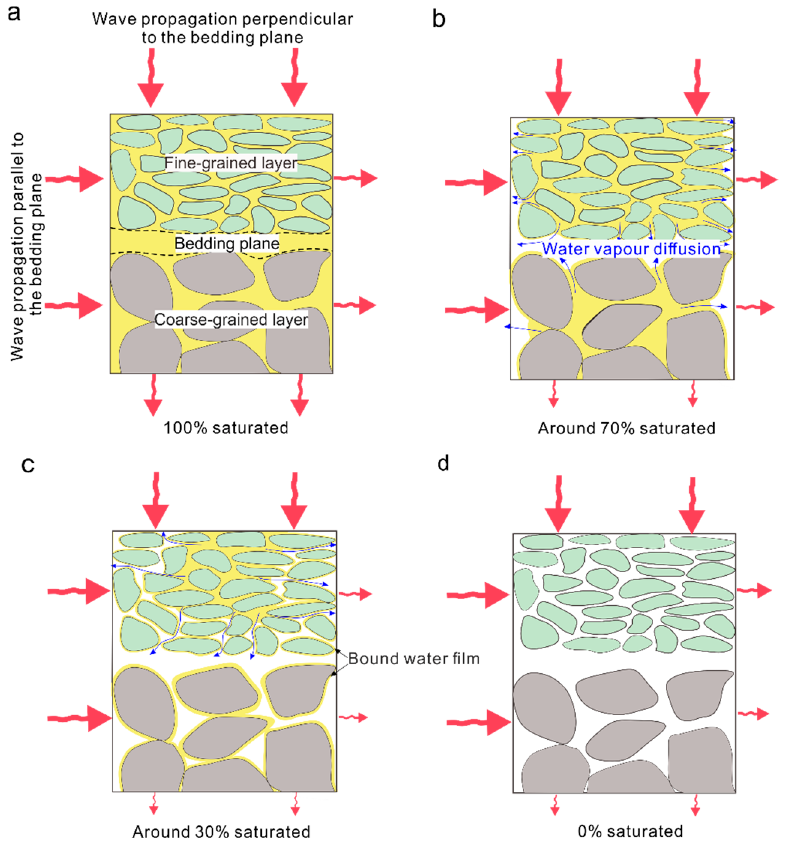
Figure 6. Schematic diagram of ultrasonic propagation mechanism of rocks with a distinct bedding plane during dehydration. ( a ) Schematic diagram of ultrasonic propagation at 100% saturation, ( b ) Schematic diagram of ultrasonic propagation at around 70% saturation, ( c ) Schematic diagram of ultrasonic propagation at around 30% saturation and ( d ) schematic diagram of ultrasonic propagation at 0% saturation (the red arrows indicate the ultrasonic wave, and of their different sizes indicate the magnitude of the P-wave velocity; the blue arrows show the direction of vapour diffusion of pore water.)